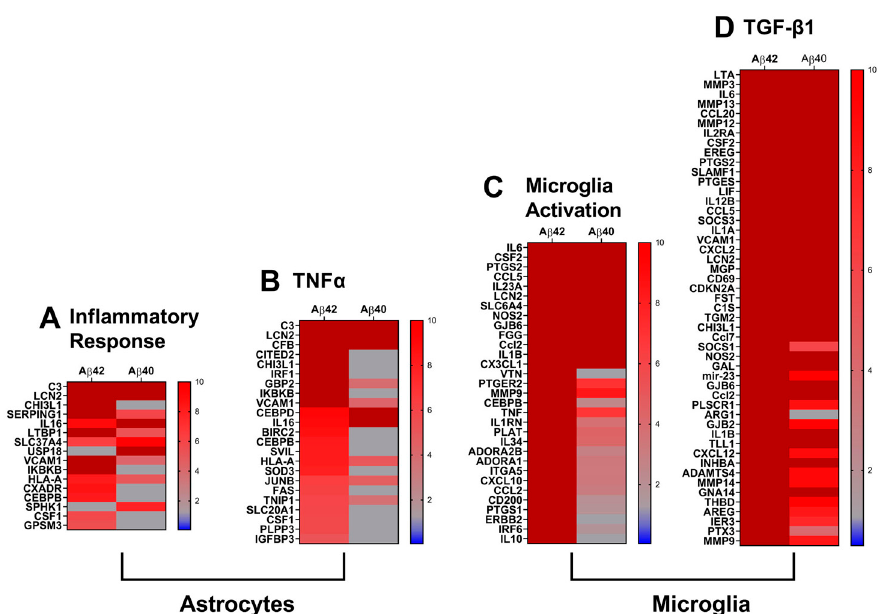
Figure 8. IPA analysis of elevated signal pathways and involved genes. Heat maps depict relative expression of genes in astrocytes associated with ( A ) inflammatory response; ( B ) TNF α , and of genes in microglia associated with ( C ) microglial activation and ( D ) TGF- β 1. Red indicates significantly increased expression; blue, significantly decreased expression; grey, no significant change. Color intensity is relative to the degree of change.